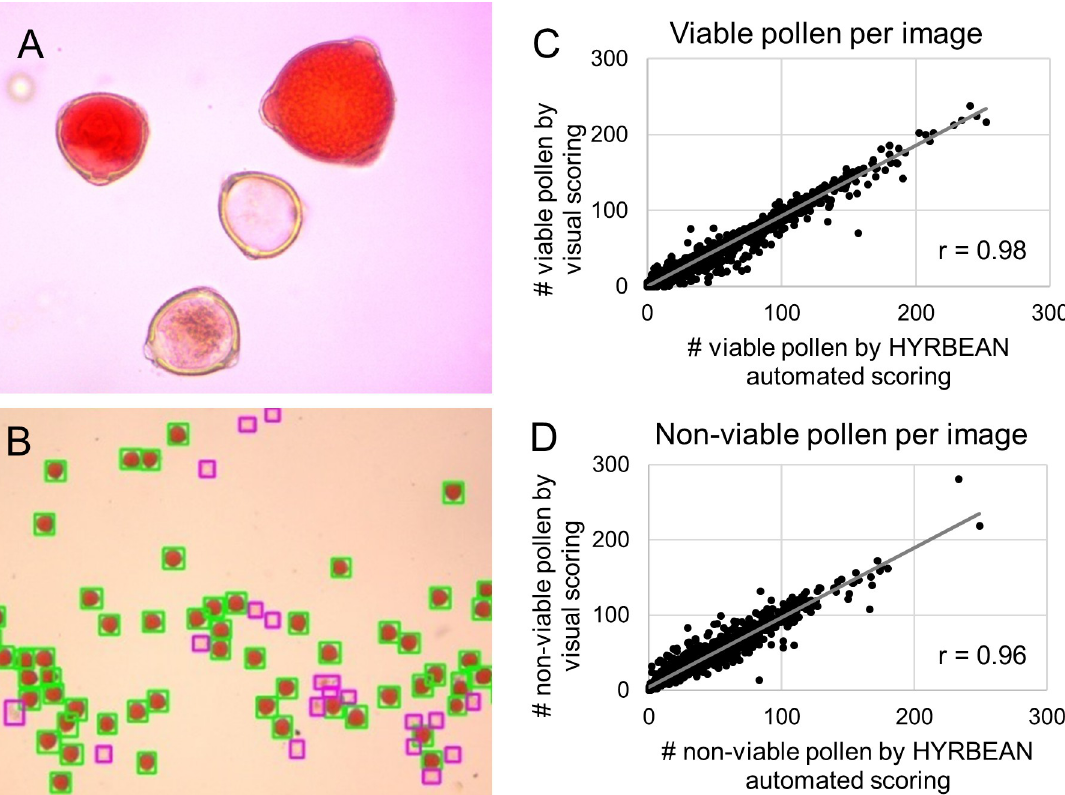
Fig 3. Detection of viable and non-viable pollen. (A) Visual differences between viable (stained red) and non-viable (transparent) pollen stained with acetocarmine. (B) Excerpt of a pollen grain image showing segmentation and pollen classification results from HYRBEAN image analysis tool. Viable pollen is boxed in yellow, non-viable pollen in blue. (C, D) Correlations between pollen counts from visual scoring and HYRBEAN automated scoring, for viable and non-viable pollen, based on 2000 images from acetocarmine pollen staining. r represents the Pearson